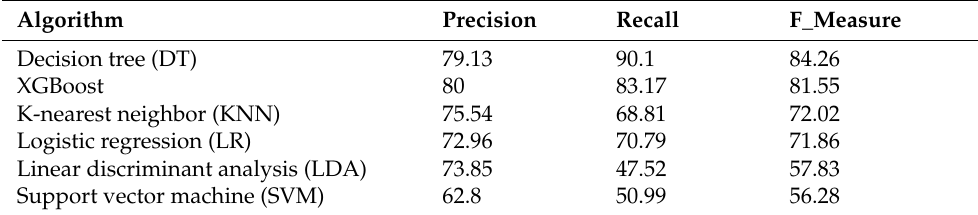
Table 6. Performance evaluation comparison based on precision, recall, and F-measure (percent).